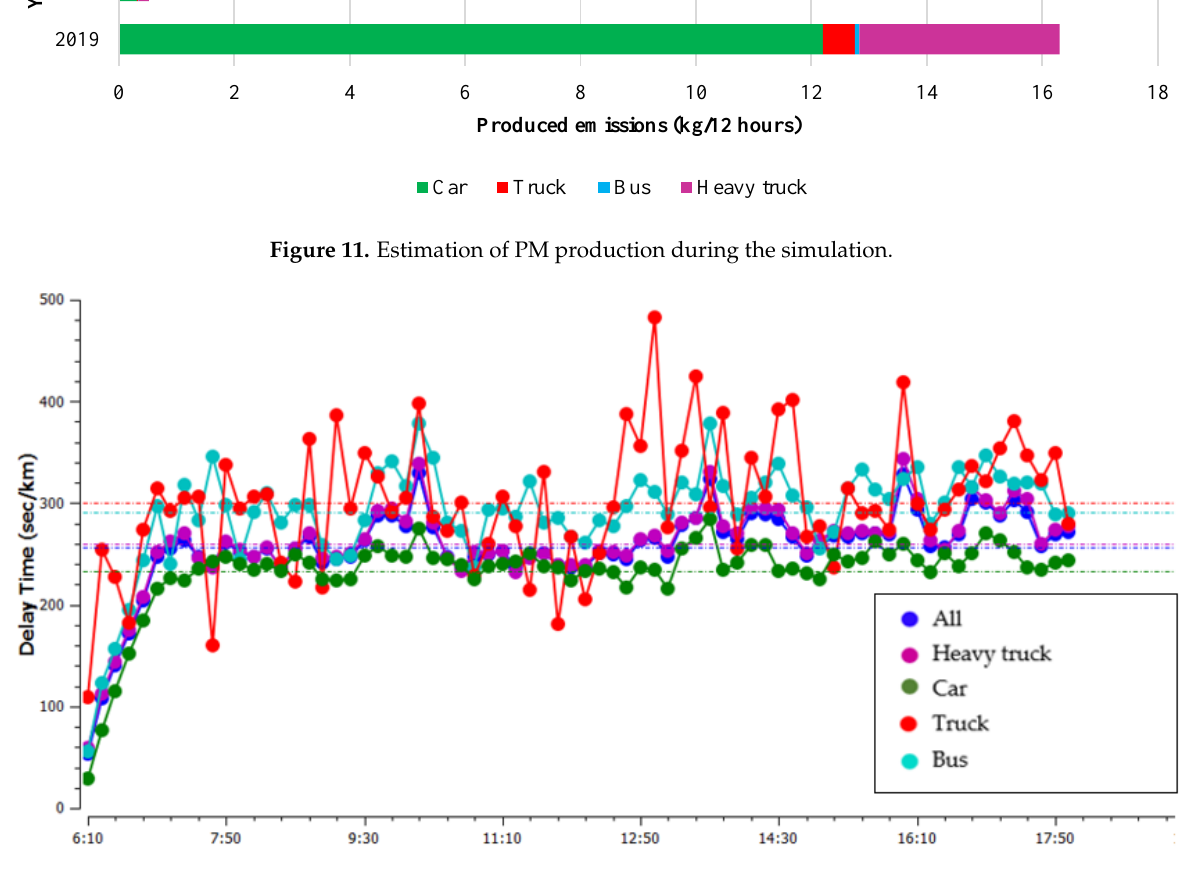
Figure 12. Delay time for each vehicle category—2019.